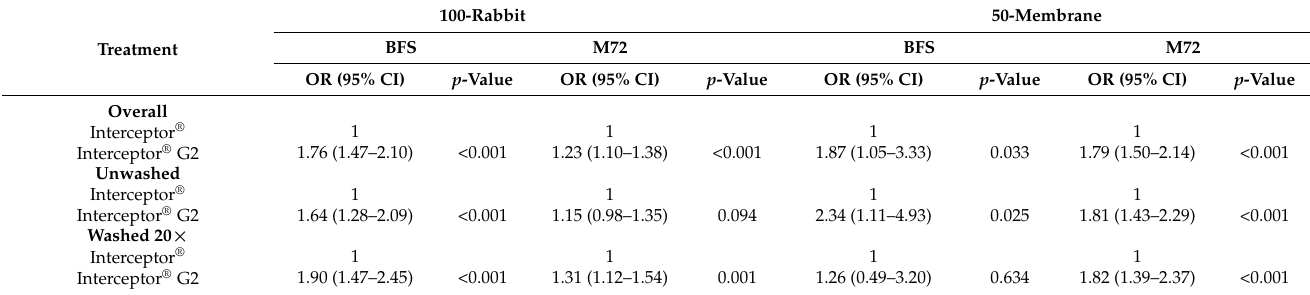
Table 7. Superiority of Interceptor ® G2 over Interceptor ® was estimated by comparing the membrane assay to the gold standard assay with pyrethroid-resistant mosquitoes. The difference in the odds of mosquito at 72-h (M72) and blood feeding success (BFS) for resistant Anopheles arabiensis measuring the superiority of Interceptor ® G2 and Interceptor ® with the gold standard with 100-rabbit compared to 50-membrane bioassays